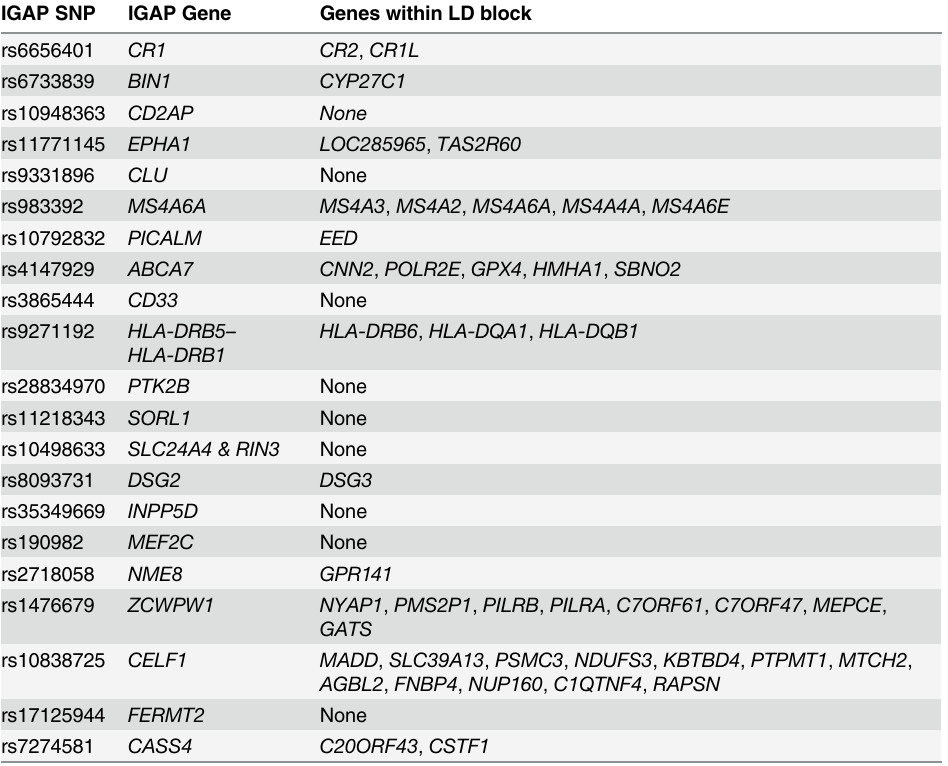
Table 2. Genes within the IGAP GWAS